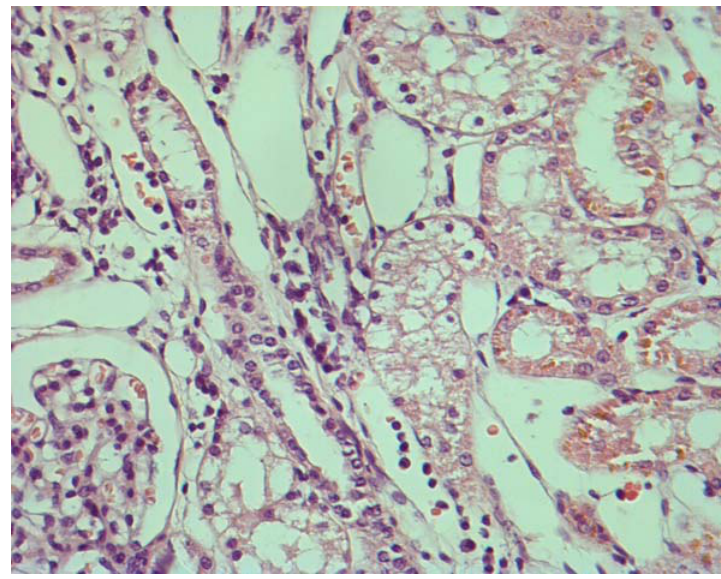
Figure 6. Renal tubular necrosis, with loss of epithelial integrity and presence of inflammatory infiltrate (HE, 400X).